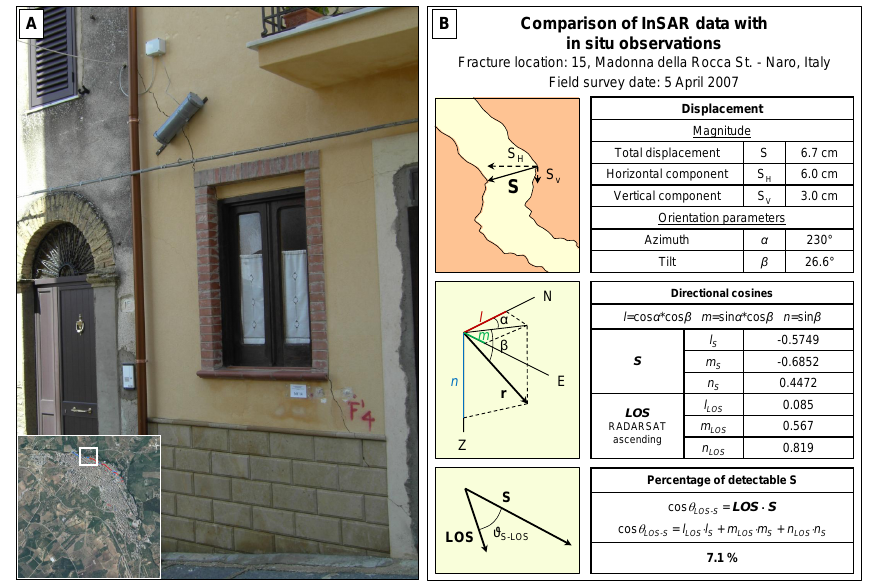
Fig. 13. Example of comparison of LOS orientation with the deformation direction detected during field surveys. (A) : Location (inset) and photo of measured fracture (photos taken on 5 April 2007). (B) : 3-D orientation characteristics of real ground displacement (S) and RADARSAT (Standard Beam, ascending mode) LOS, and evaluation of LOS-detectable ground displacement [%]. LOS and S vectors are identified by azimuth ( α ), tilt ( β ) and directional cosines ( l , m and n , respectively, in the N, E and vertical or Z direction).